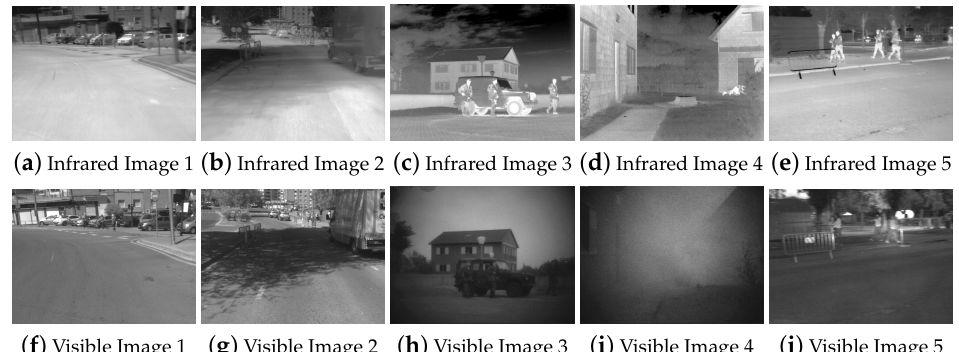
Figure 6. ( a – j ) Some examples of infrared and visible images from the used image dataset. The images in the first row are infrared images, and the images in the second row are visible